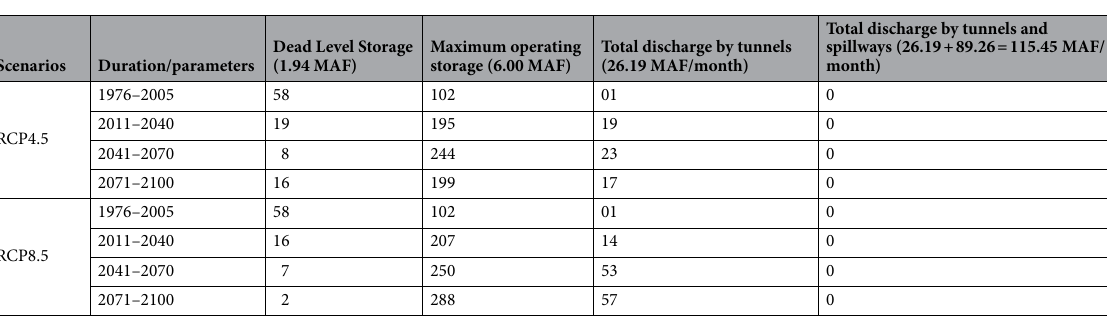
Table 3. Important information about water availability and response of Tarbela Reservoir under changing climate in the Upper Indus Basin, Pakistan. The entries in columns 3–6 show the number of times exceed the parameter of the reservoir mentioned on the top of each column under each climate change scenarios for different time